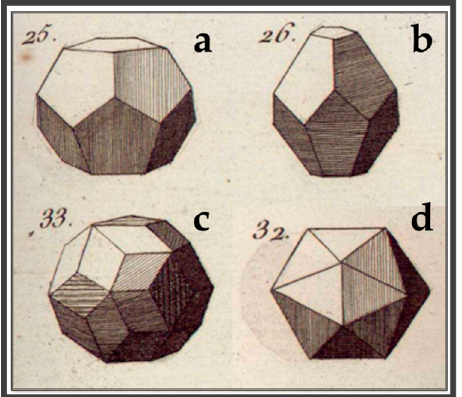
Figure 1. Forms with non-crystallographic pentagonal external symmetries by Romé de L’Isle. ( a ) Regular dodecahedron. ( b ) Elongated or pyramidal dodecahedron. ( c ) Regular triacontahedron. ( d ) Icosahedron. Illustration adapted from Table II ( Le Cube ou L’Hexaèdre et ses Modifications ) in Volume IV of Cristallographie [1].